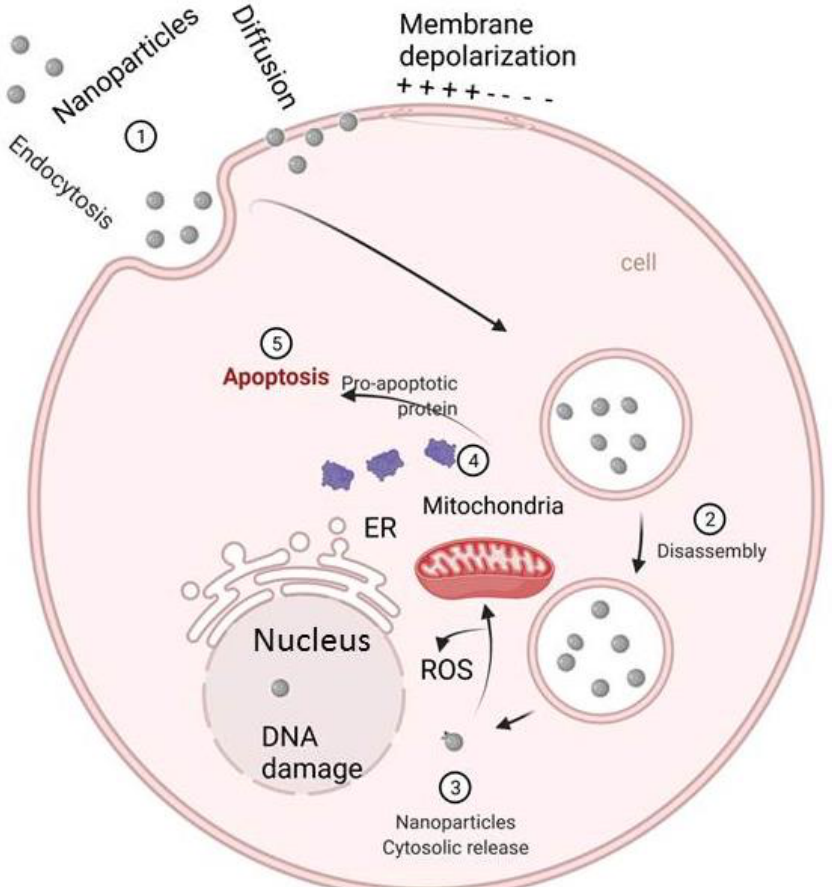
Figure 1. Mechanism of antimicrobial activity of nanoparticles against fungi Nanoparticles inhibit fungal growth by entering the cells through endocytosis and diffusion processes, and their entry will eventually lead to apoptosis. After entering into the cells, nanoparticle inhibits cell wall/membrane synthesis, disruption of energy transduction, production of ROS, enzyme inhibition, and reduced DNA production, DNA damage, and protein damage. Table 1. Antifungal effects of various types of nanoparticles.